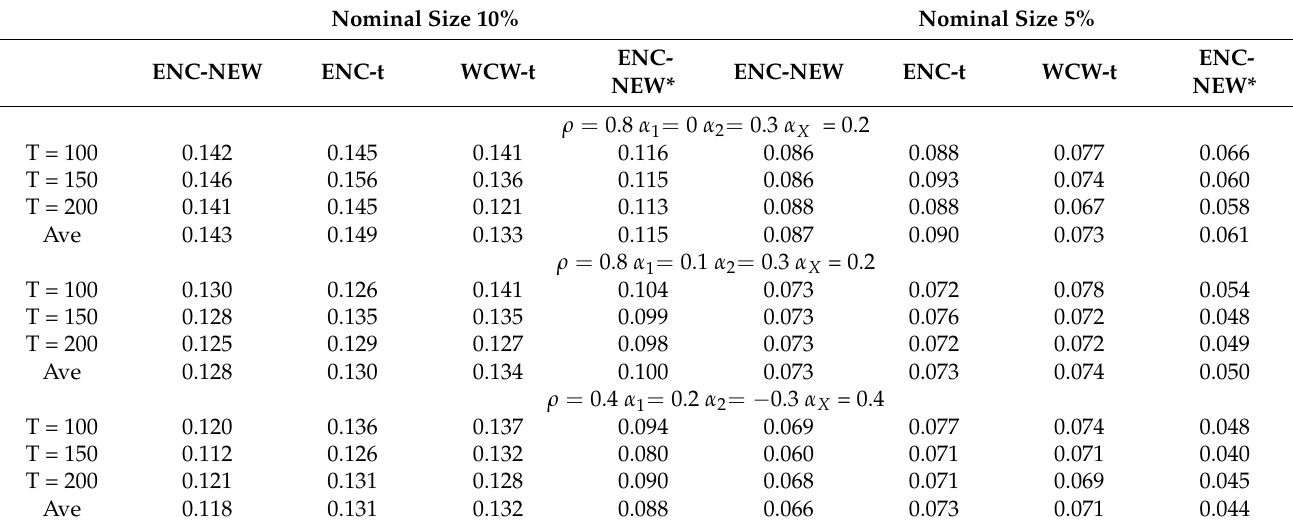
Table 5. Empirical Size with an out-of-sample bias and P/R =